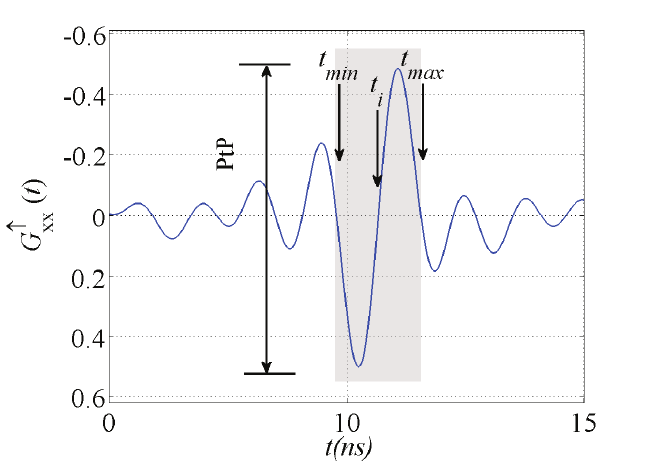
Figure 1. Measured Green’s function in the time domain, where t min and t max define the time window focused on the surface reflection in which inversion is performed. Time t i corresponds approximately to the surface interface in the space domain, and the maximum amplitude of Green’s function is defined by the peak-to-peak P tP